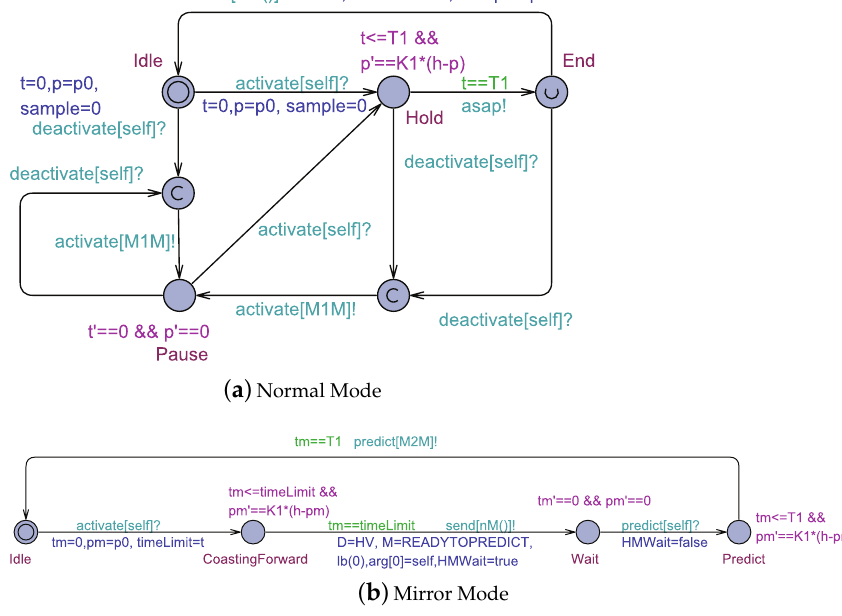
Figure 6. A normal mode and a mirror mode of the HVAC